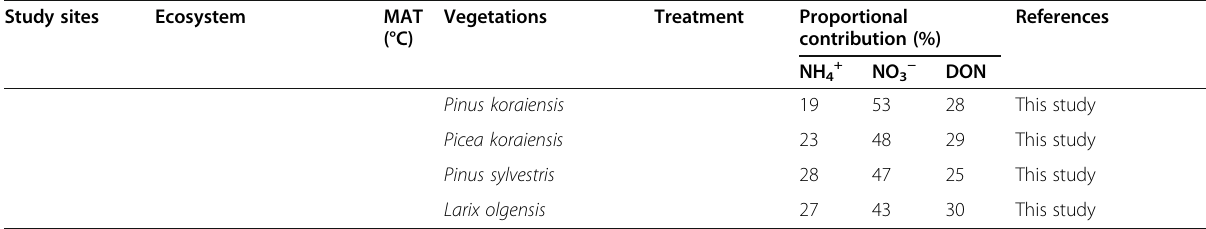
Table 1 The proportional contribution of different N forms to plant N uptake in forest trees by using the 15 N natural abundance method